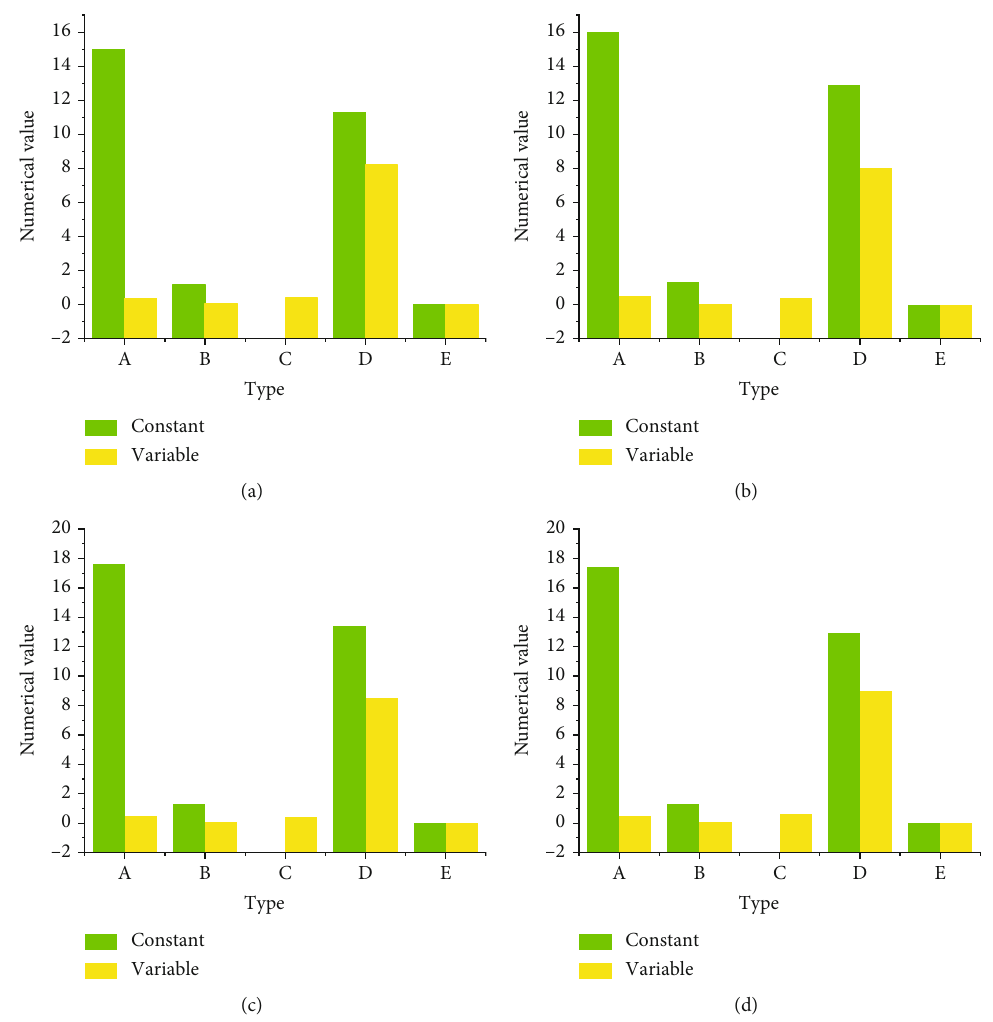
Figure 9: Result statistics of the regression coe ffi cient of each variable ((a) pretending expression, (b) indi ff erent expression, (c) contempt expression, and (d) sincere expression. A: B value in nonstandardized coe ffi cient; B: standard error in nonstandardized coe ffi cients; C: standardization coe ffi cient; D: t value; and E: